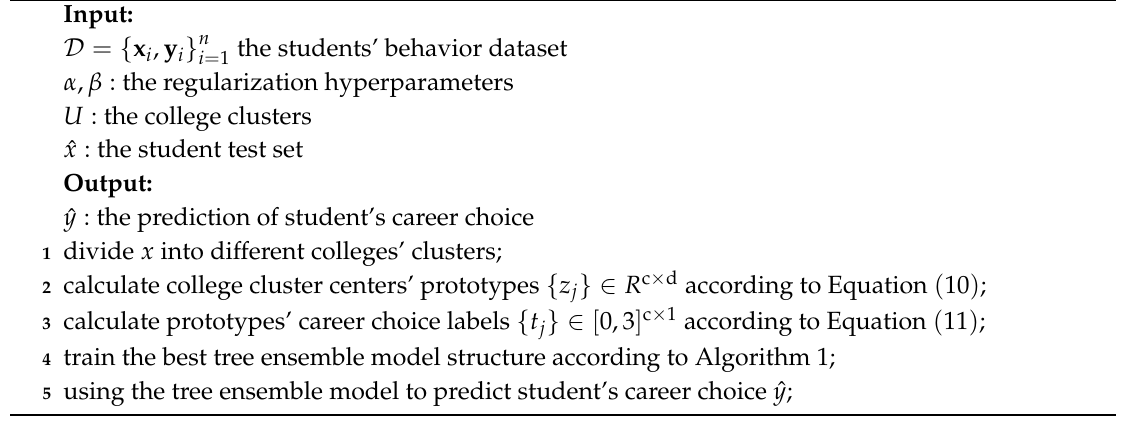
Algorithm 2: The Approach Cluster Centers Based On XGBOOST (ACCBOX)